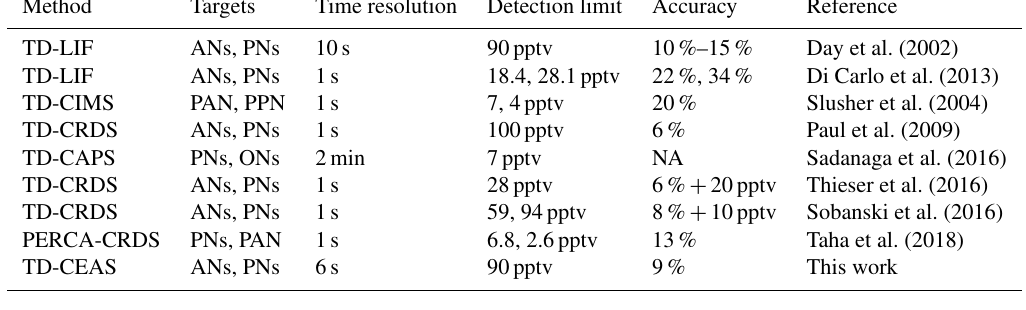
Table 2. Typical thermal dissociation methods to measure organic nitrates.